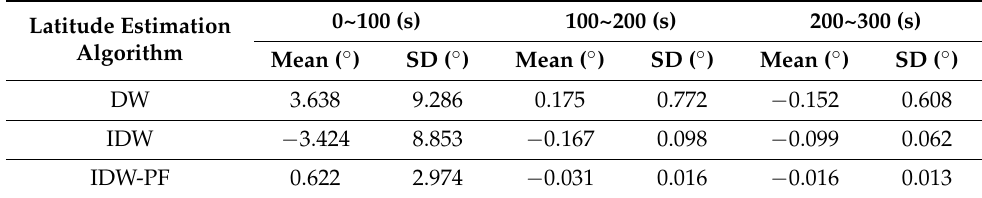
Figure 3. Curves of latitude estimation error. Table 2. Statistical results of latitude estimation errors.